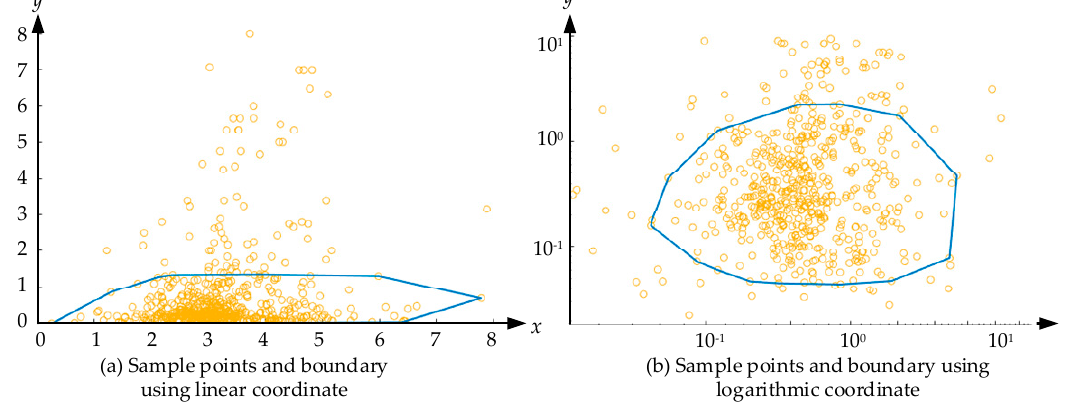
Figure 6. Generating boundaries of sample points with a linear coordinate and a logarithmic coordinate (the confidence coefficient is 0.85). ( a ) Sample points and boundary using linear coordinate; ( b ) Sample points and boundary using logarithmic coordinate.